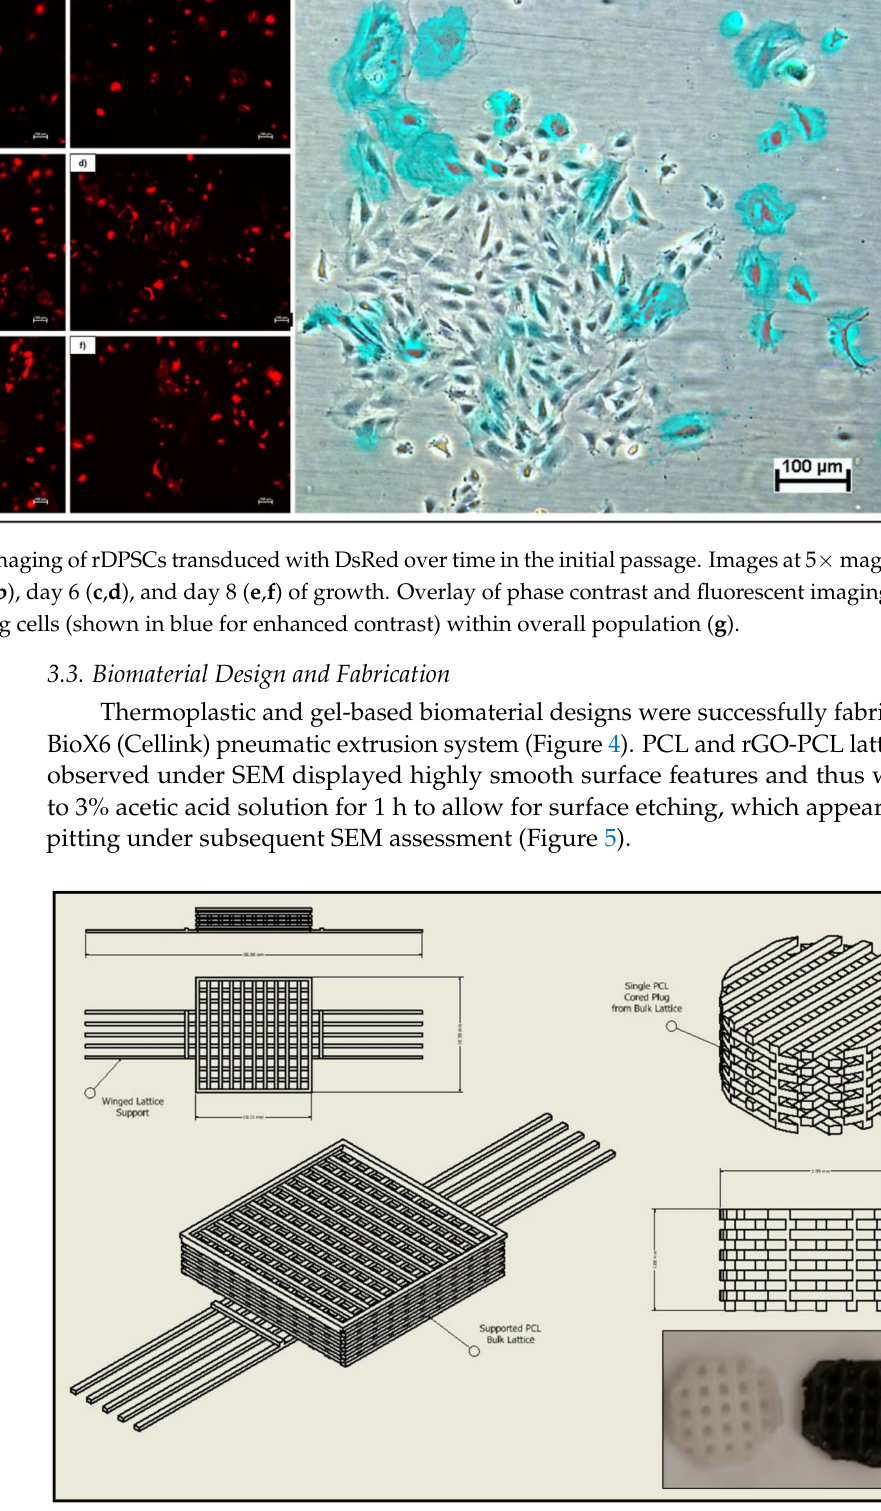
Figure 4. CAD schematic for print design with original structure and cored scaffold sample. Image inset depicts final printed scaffold samples of both PCL ( Left ) and rGO-PCL ( Right